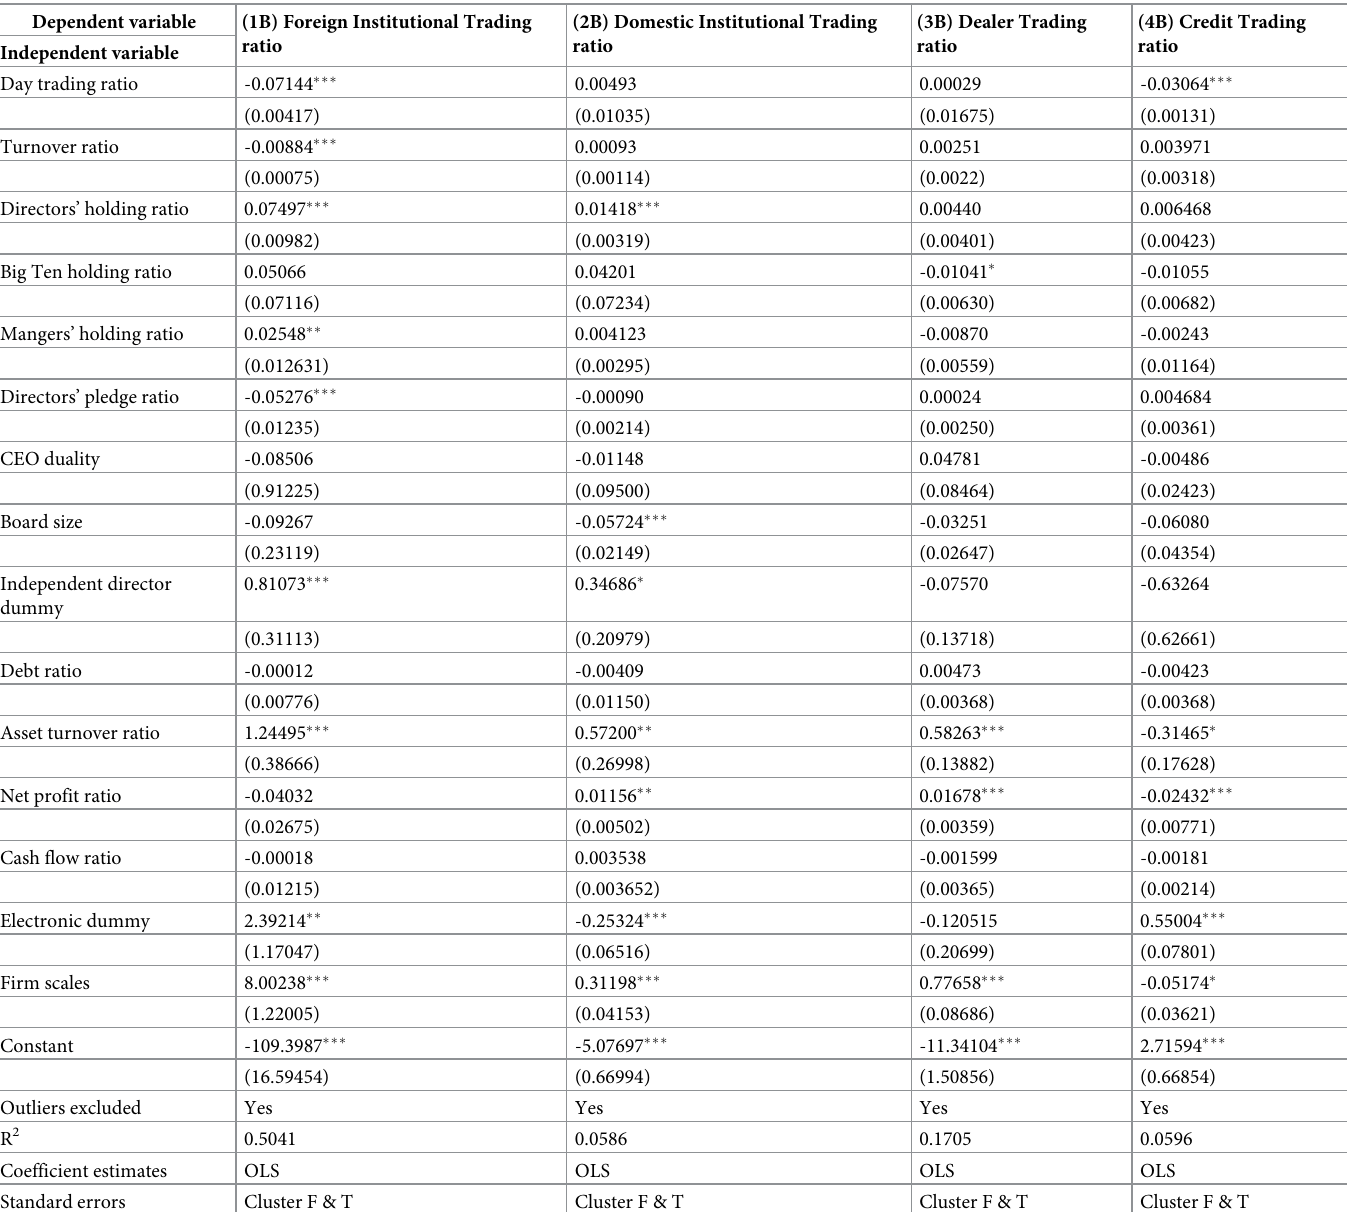
Table 4. Results of trading behaviors for diverse